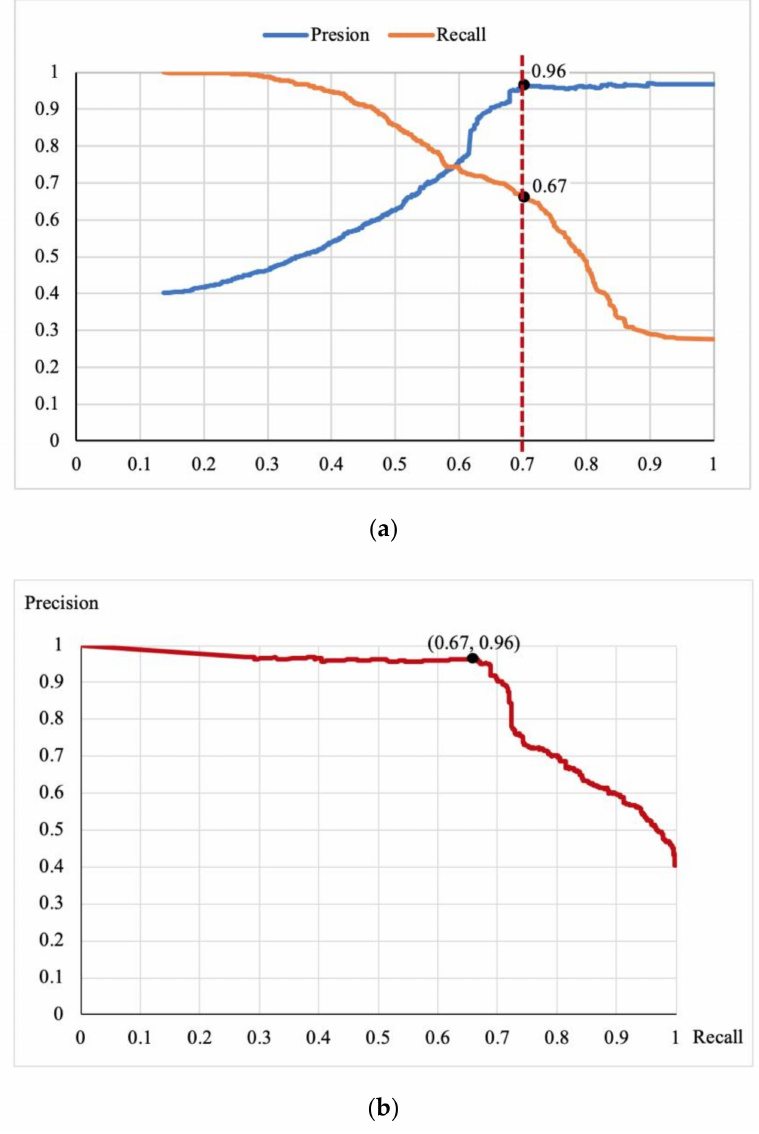
Figure 5. ( a ) Precision curve and recall curve changing with different thresholds; ( b ) curve in which recall varies with